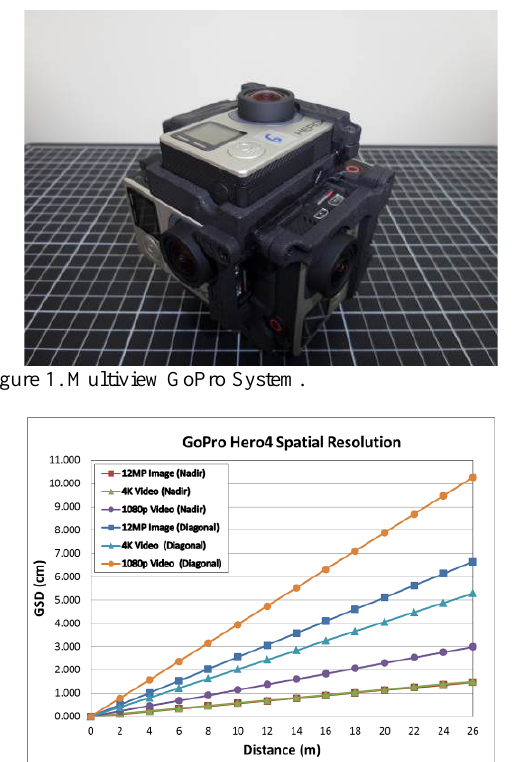
Figure 2. Ground sampling distances in different